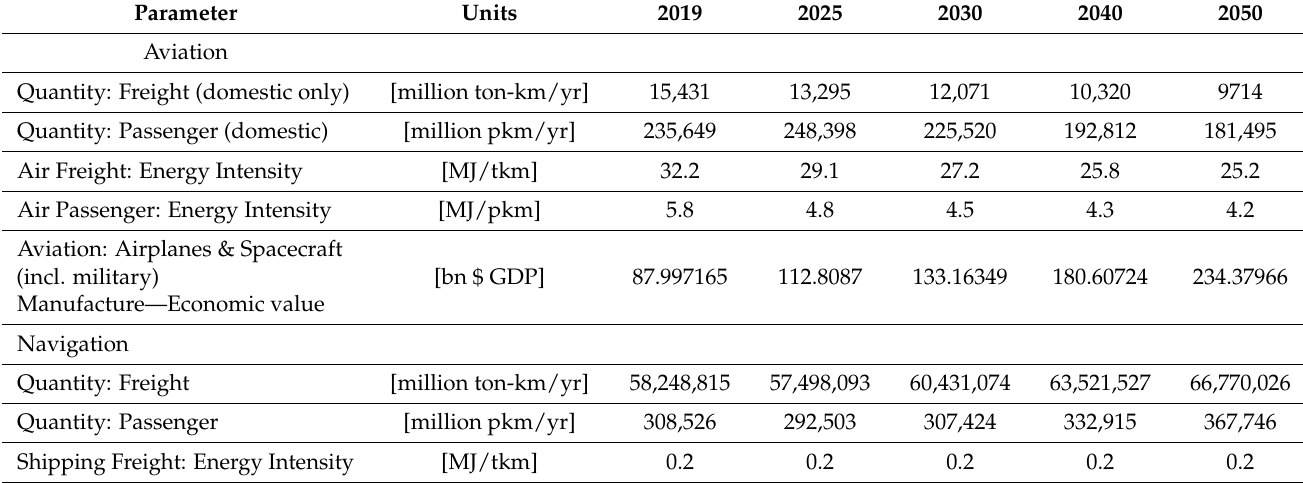
Table 4. Projection of transport demand based on the changing demand in kilometers for the OECM 1.5 ◦ C